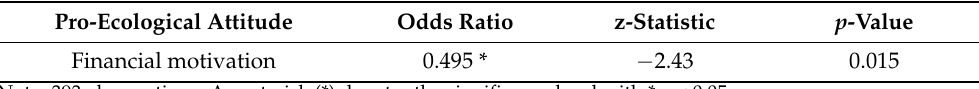
Table 8. Logistic regression: developed a pro-ecological attitude. Pro-Ecological Attitude Odds Ratio z-Statistic p -Value Financial